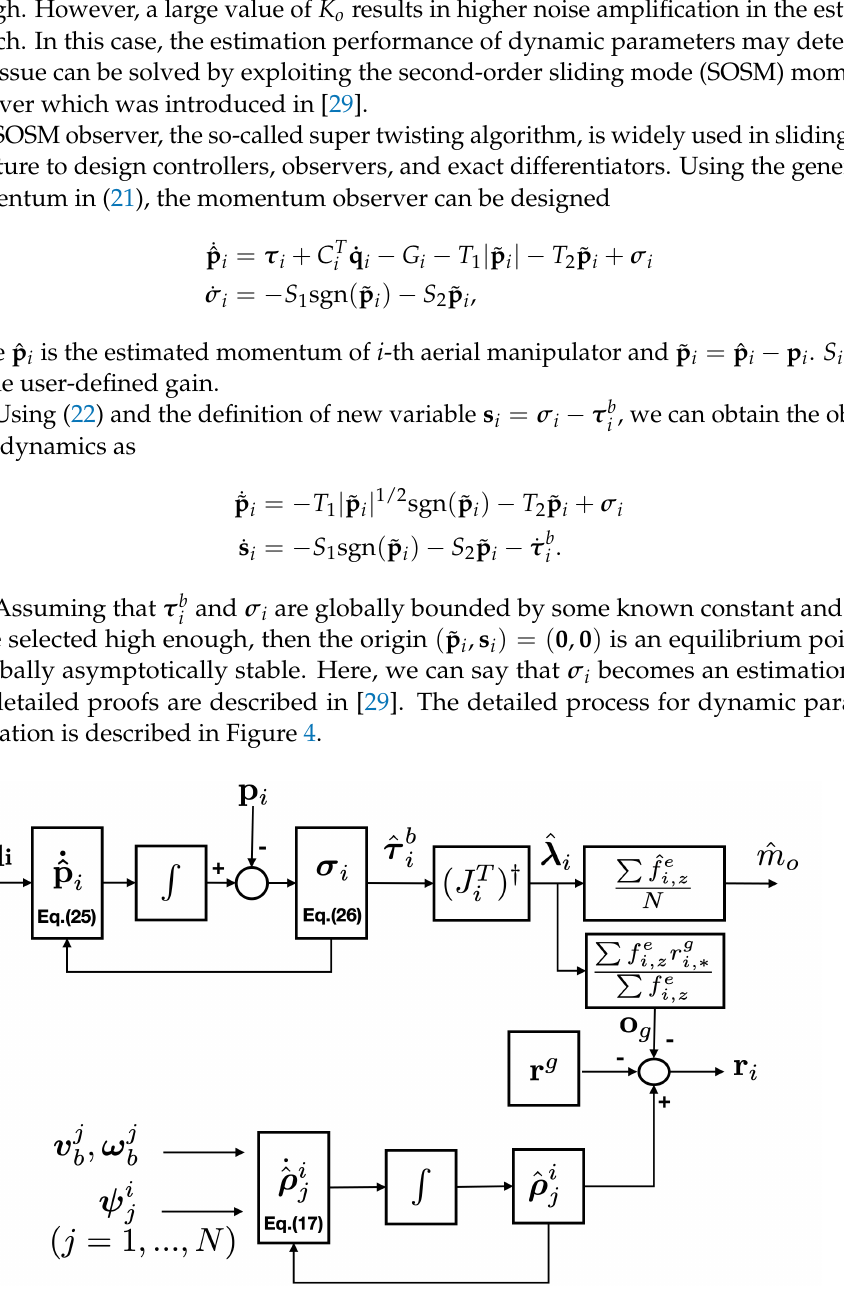
Figure 4. The proposed structure for the dynamic parameter